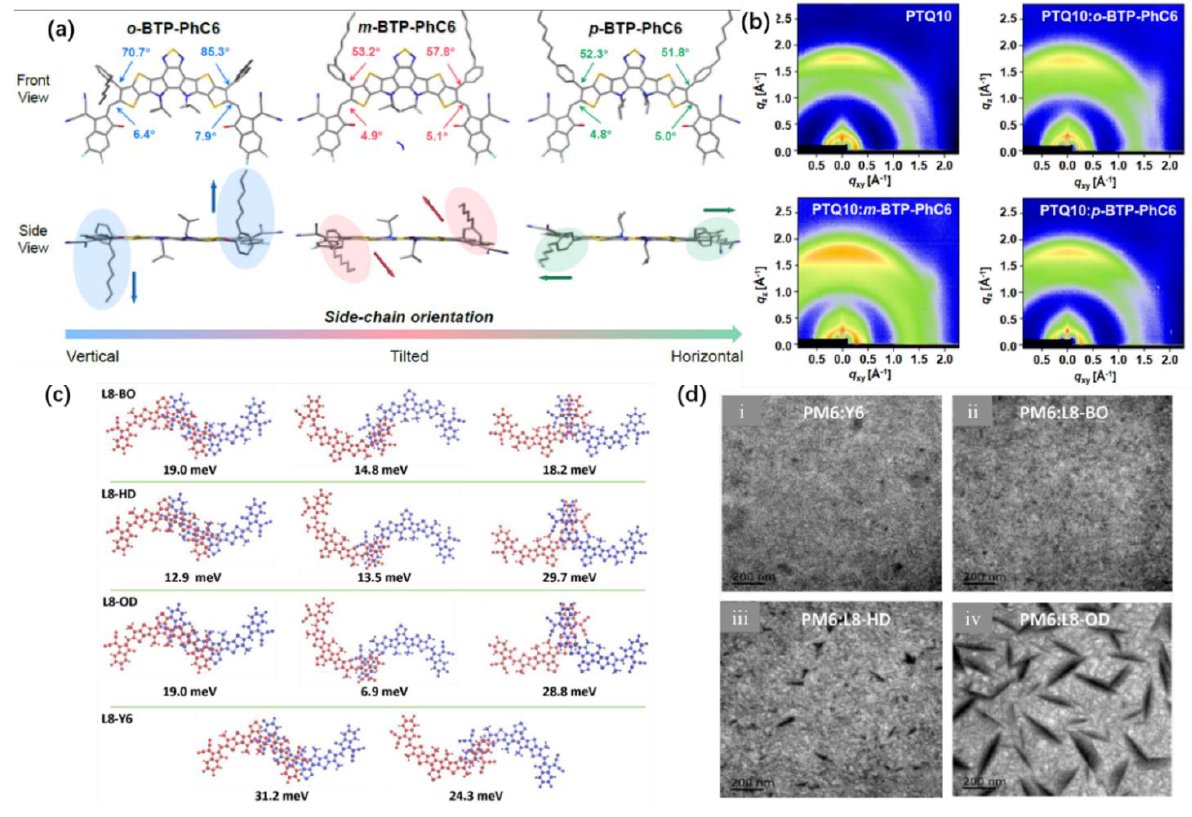
Figure 7. ( a ) Optimized geometry o-BTP-PhC6, m-BTP-PhC6, and p-BTP-PhC6 of by DFT calcula- tion [75]. ( b ) 2D GIWAXS images of a neat PTQ10 film; PTQ10:o-BTP-PhC6, PTQ10:mBTP-PhC6, and PTQ10:p-BTP-PhC6 blend films [75]. ( c ) Electronic coupling (meV) for L8-R (L8-BO, L8-HD, L8- OD), and Y6 dimers with different crystal packing motif. The electronic couplings for dimers of L8-